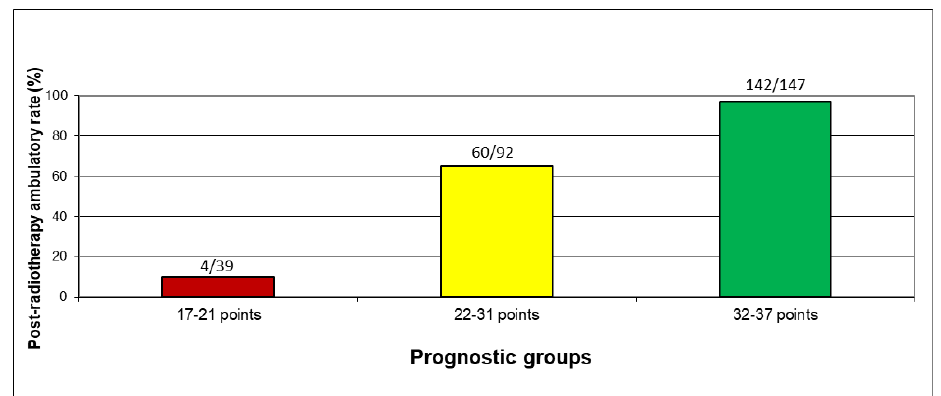
Figure 1. Scoring points for individual patients and post-radiotherapy ambulatory rates (in %). Colours represent the prognostic groups, i.e., red = least favorable group, yellow = intermediate group, and green = most favorable group.